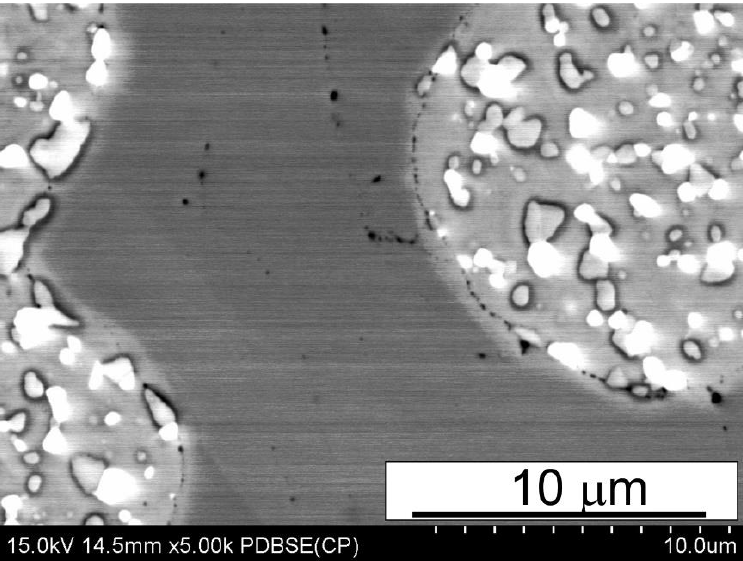
Figure 9. Microstructure of iron-high speed steel grain boundary in T15+50%Fe and b) T15 materials spark plasma sintered at 1050 °C; SEM.